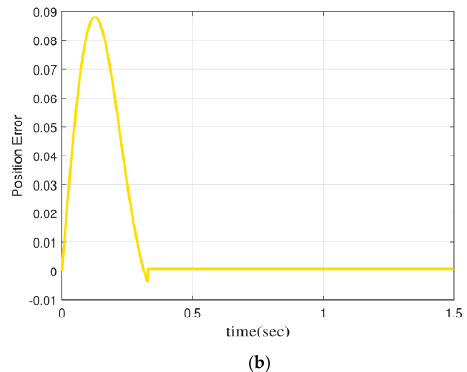
Figure 6. a ) Normal PID control+MRAO, ( b ) FOMRAC+MRAO. Figure 6. ( a ) Normal PID control+MRAO, ( b ) FOMRAC+MRAO.